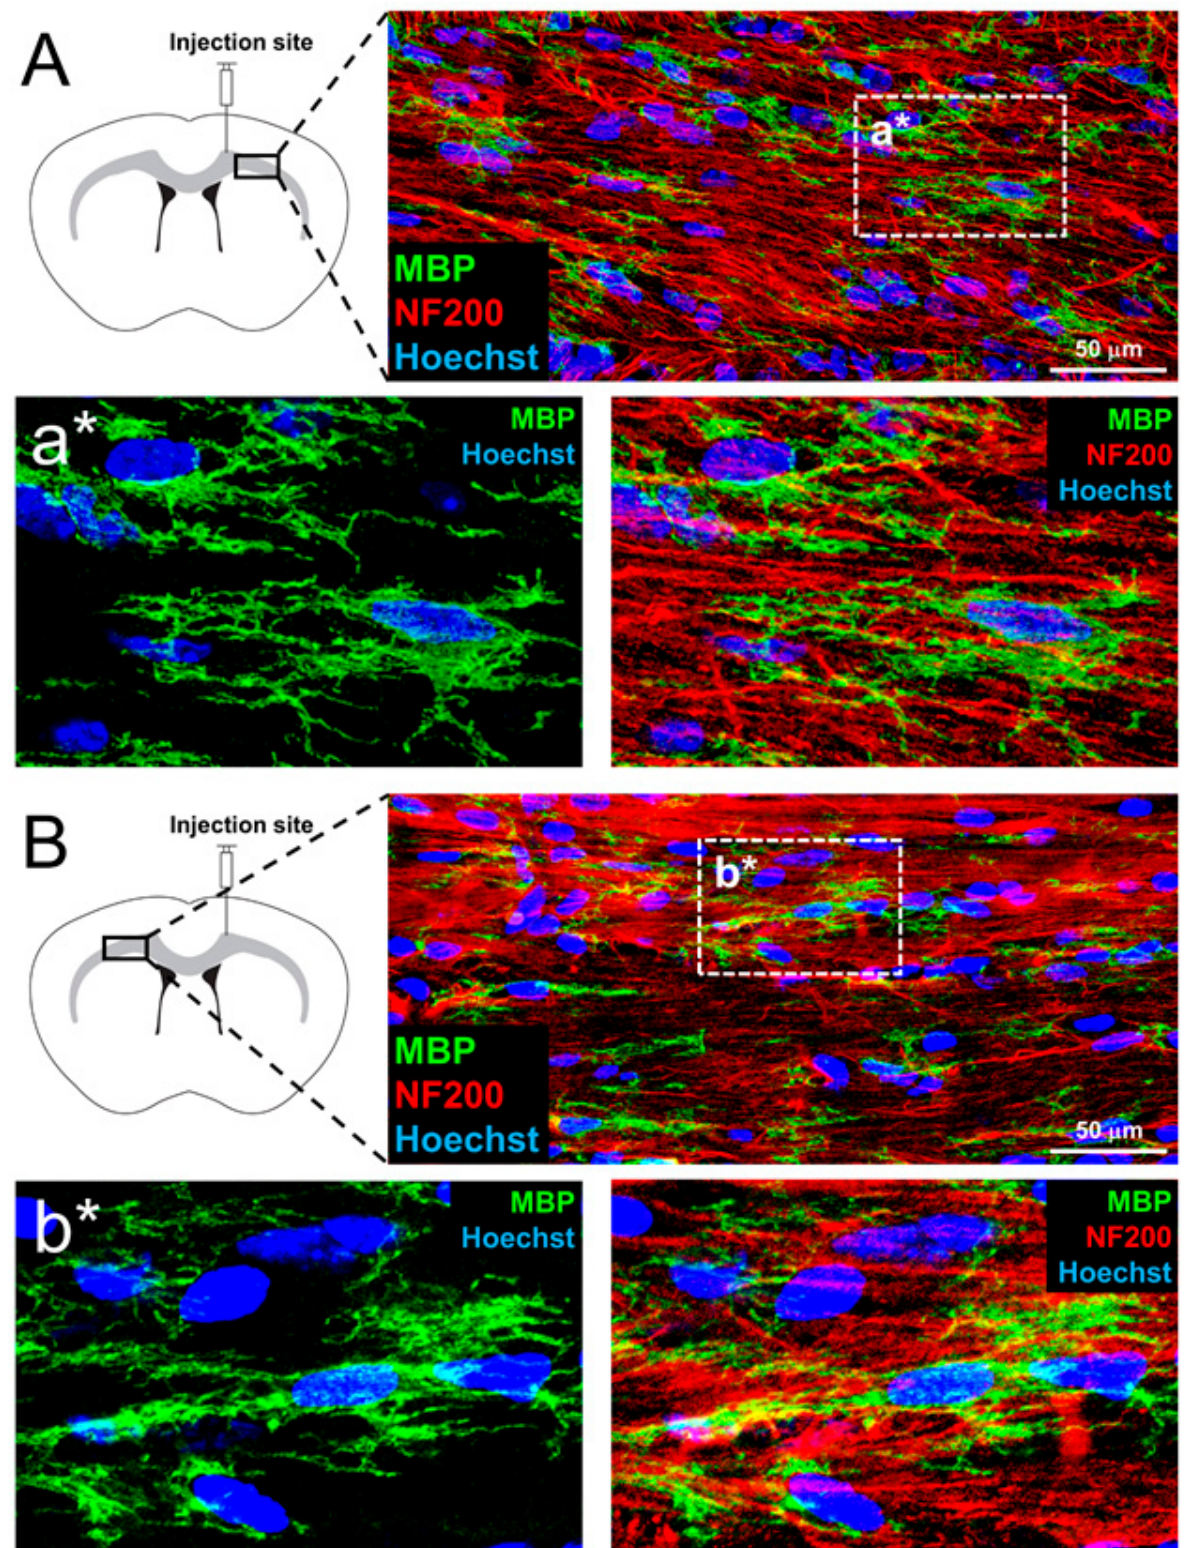
Figure 5. Migration and maturation of aMSC-derived OPs into myelinating OLs in myelin-deficient shiverer mouse model, 6 weeks post-transplantation into the corpus callosum was performed at the right hemisphere ( A1 ). MBP-positive OLs were observed in the corpus callosum of, on both the right ( A ) and the left ( B ) 6 weeks post-transplantation. Multiple MBP-positive processes along NF200-positive axons ( a* , b* ). n = 5 mice.